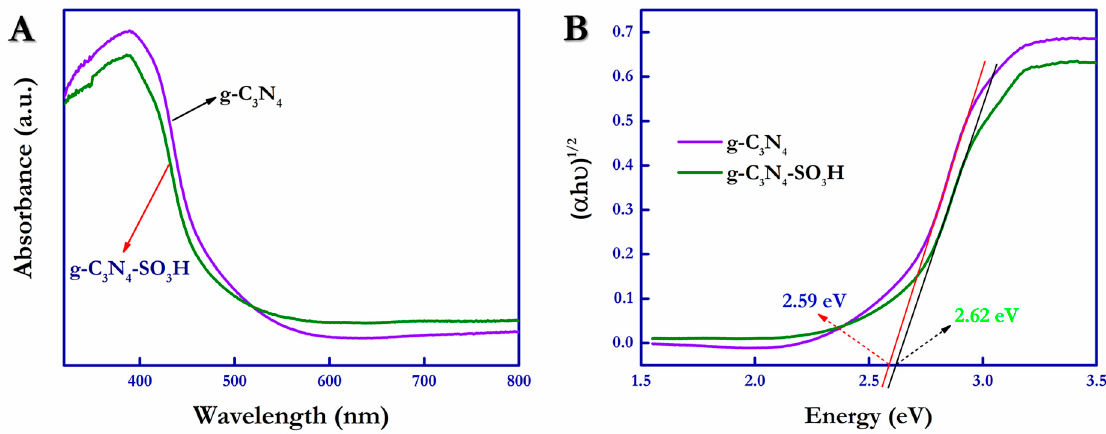
Figure 7. UV–visible DRS ( A ) and Tauc plot ( B ) of prepared g-C 3 N 4 and g-C 3 N 4 –SO 3 H. The flat band potentials (V FB ) of the photocatalysts, g-C 3 N 4 and g-C 3 N 4 –SO 3 H, were obtained using Mott–Schottky (M-S) analysis in the presence of the supporting electrolyte (0.1 M Na 2 SO 4 ) under dark conditions. In Figure 8A,B, the M-S plots of pure g-C 3 N 4 and functionalized g-C 3 N 4 –SO 3 H are illustrated, and from the positive slope obtained, the n-type semiconducting nature of g-C 3 N 4 due to the n-type nitrogen donor atoms was affirmed. Based on the linear fitting of the obtained data, the conduction bands for the g-C 3 N 4 and g-C 3 N 4 –SO 3 H materials were measured with the intercept, and the values were − 0.95 eV and − 1.09 eV, respectively. Thus, the Mott–Schottky analysis confirmed that the CB of g-C 3 N 4 –SO 3 H ( − 1.09 V) shifted to a more negative potential than the bulk g-C 3 N 4 ( − 0.95 V), resulting in g-C 3 N 4 –SO 3 H being the capable candidate for both photocatalytic oxidation and reduction reactions.